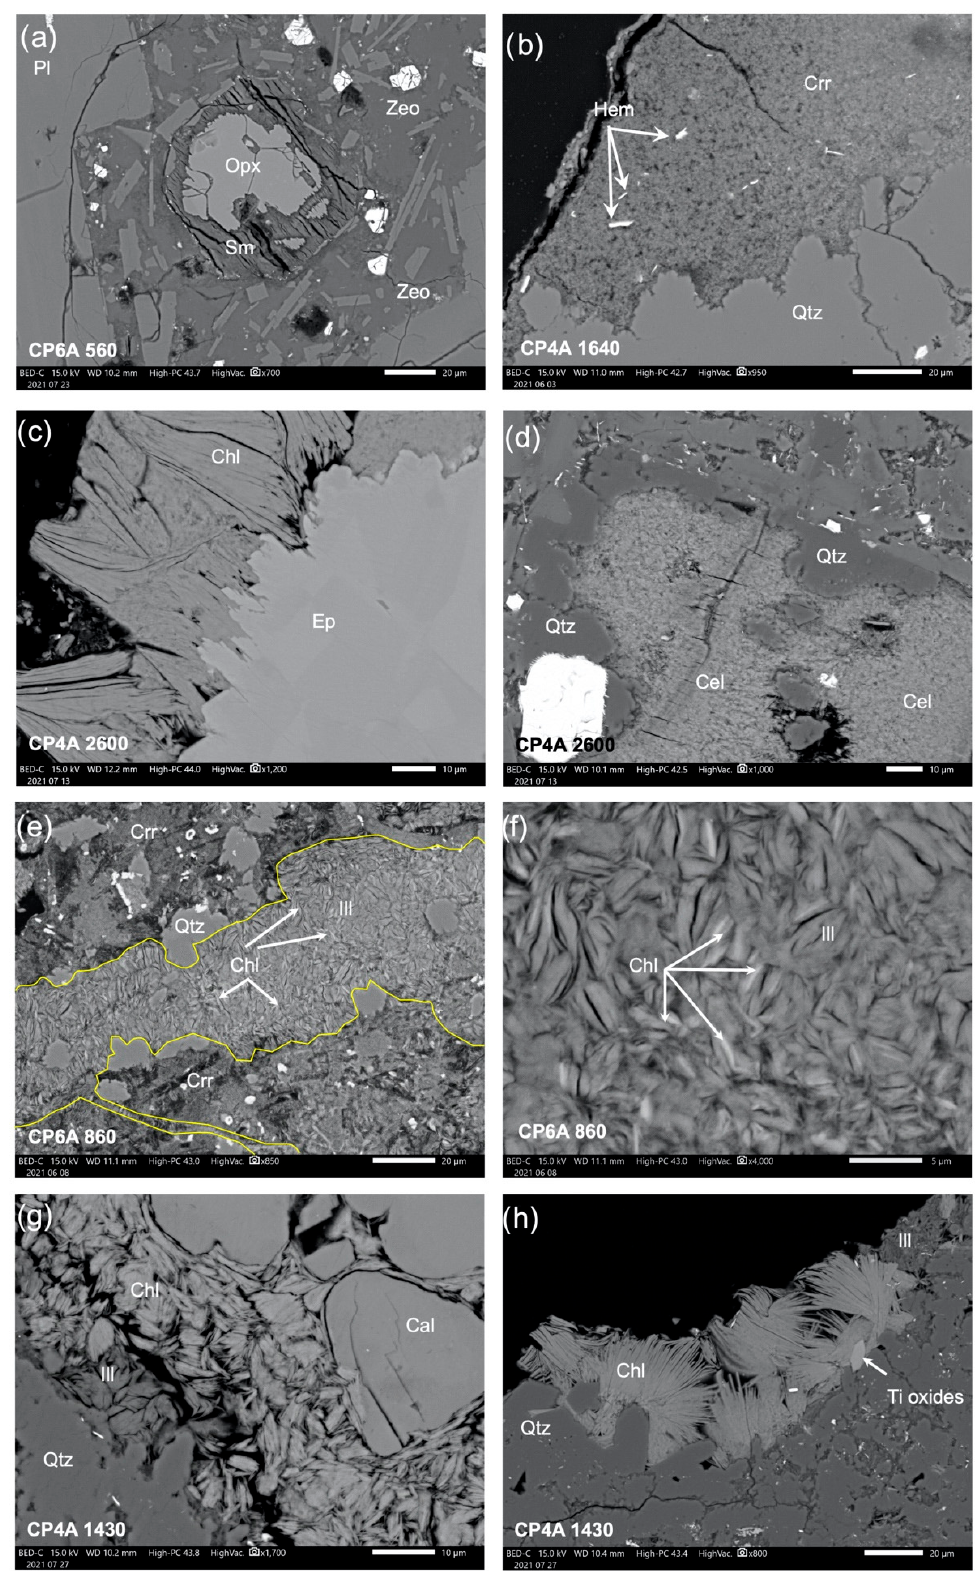
Figure 2. Mineral associations representative of pervasive alteration ( a – d ) and fracture-controlled alteration ( e – h ). Observations conducted by SEM in thin sections of cuttings fixed in epoxy in CP-4A and CP-6A wells. Cal: calcite, Chl: chlorite, Cpt: clinoptilolite, Crr: corrensite, Ep: epidote, Hem: hematite, Ill: illite, Opx: orthopyroxen, Pl: plagioclase, Sm: smectite, Qtz: quartz , Zeo: zeolite.